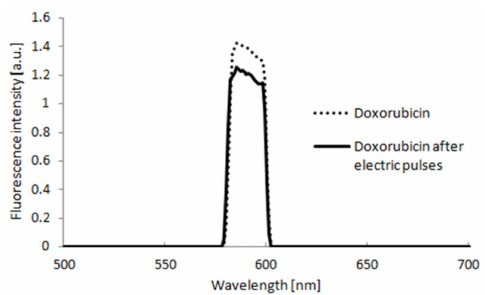
Figure 3. Fluorescence intensity of doxorubicin solutions without and after application of electrical